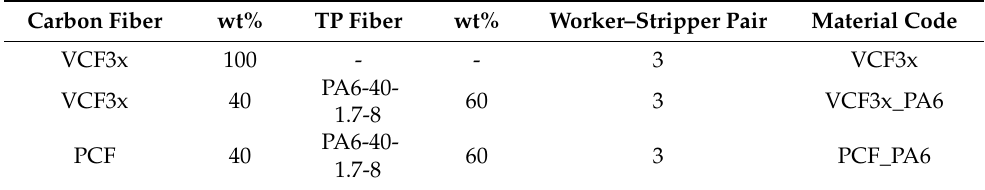
Table 2. Processed fiber blends for fiber length measurement regarding web formation.